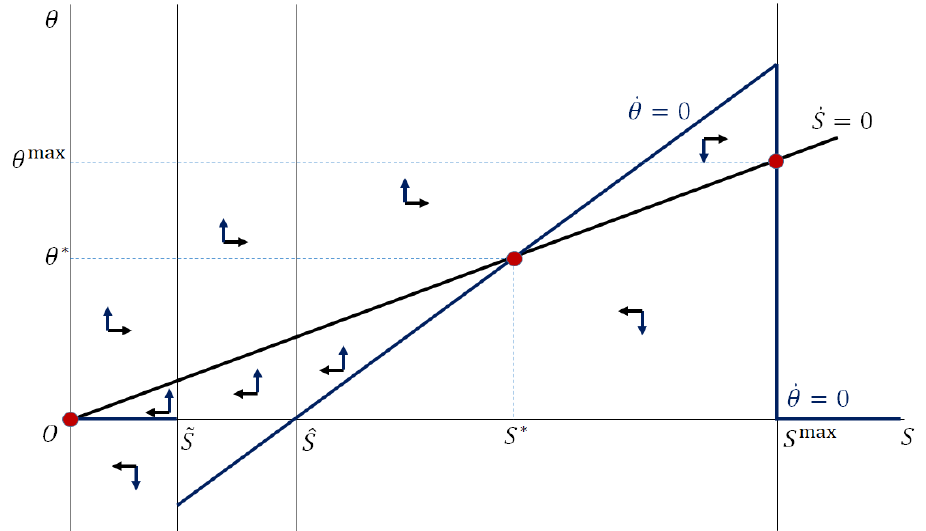
Figure 4. Steady states in the symmetric open-loop Nash